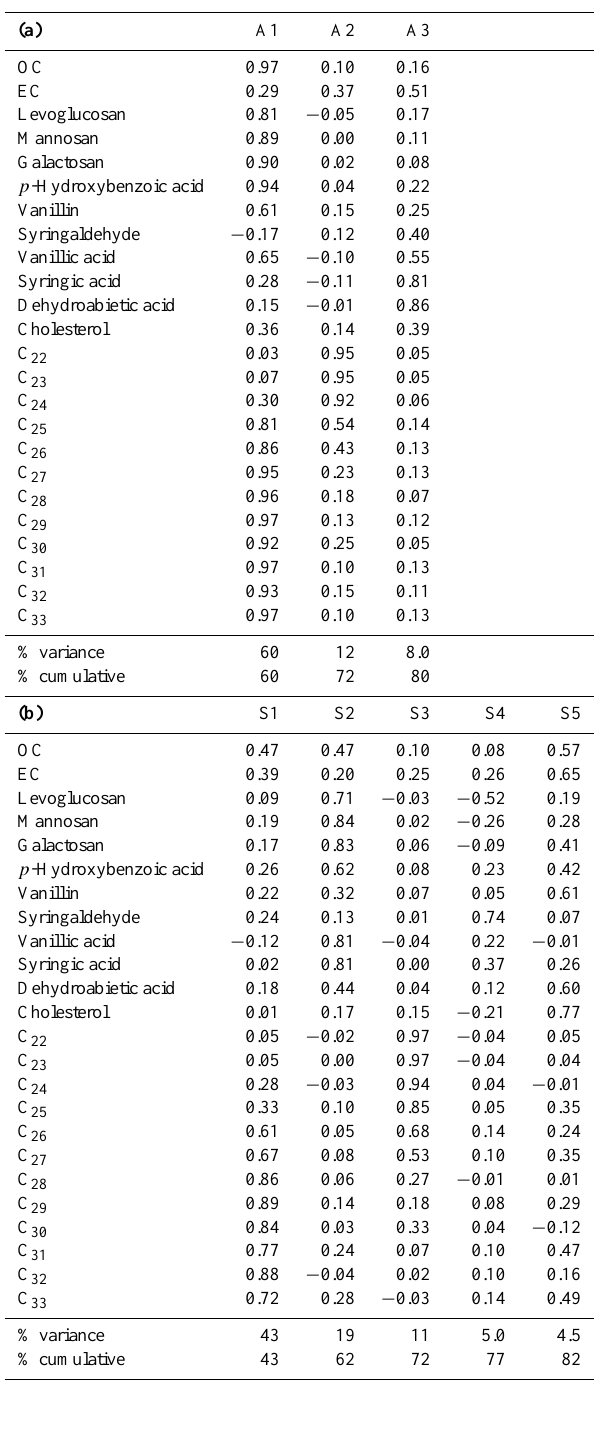
Table 2. (a) Factor loadings from varimax-rotated PCA of PJ_A data. A1–A3 indicate factors. (b) Factor loadings from varimax- rotated PCA of PJ_S data. S1–S5 indicate